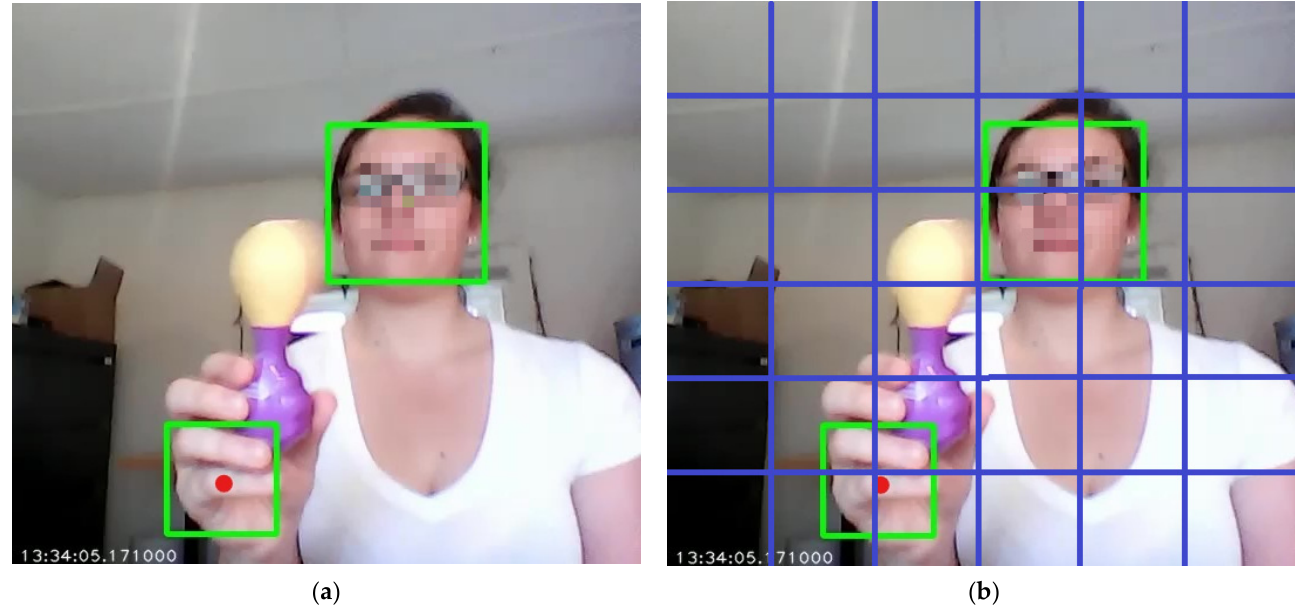
Figure 2. Robotic face perspective during lab-based HRI experiments ( a ), and 6 × 6 gridded version representing the sensory environment of the robot used for simulations ( b ).